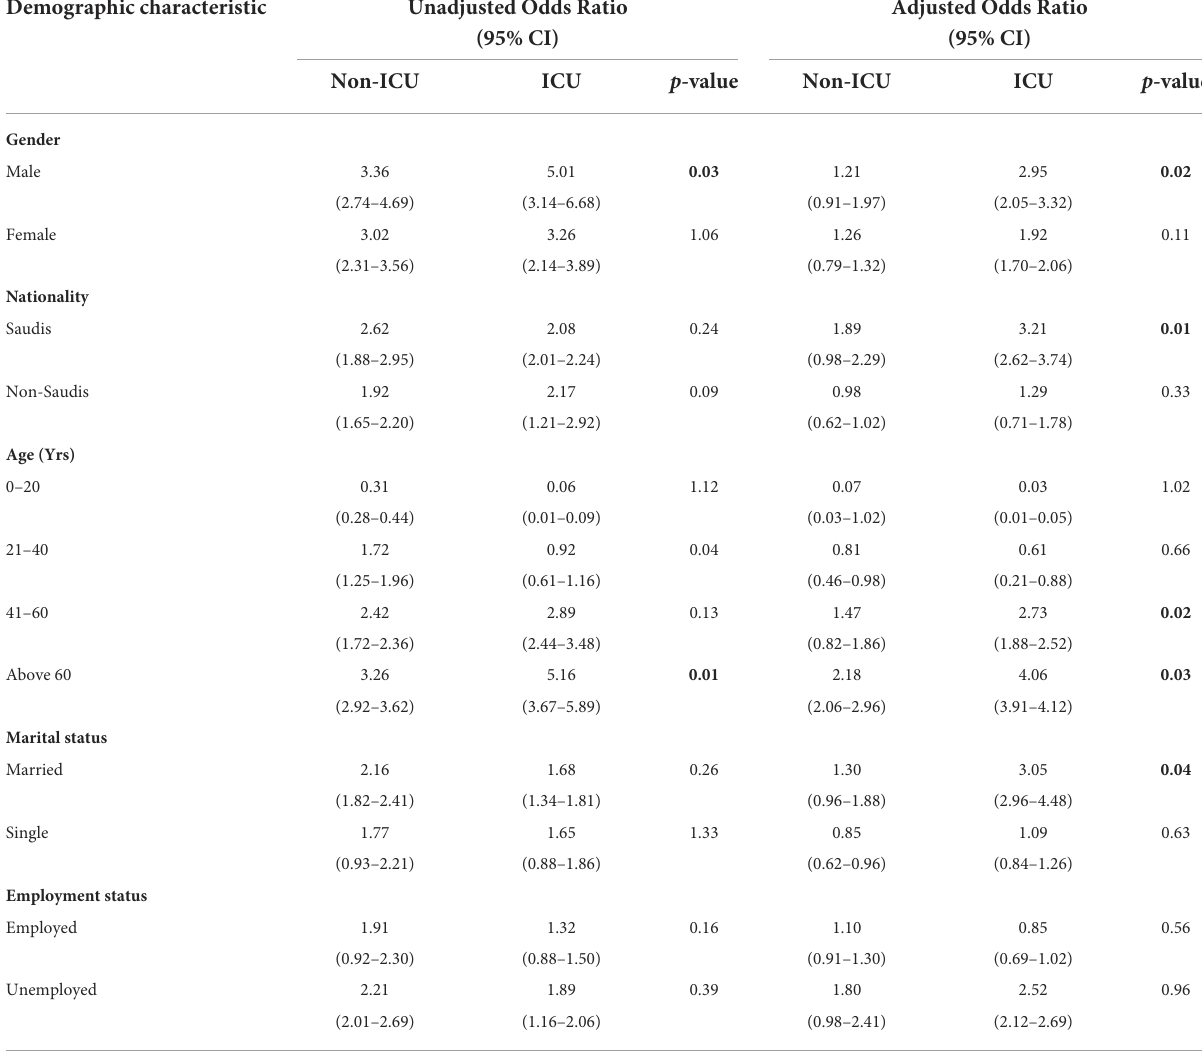
TABLE 3 Association between potential risk factors and COVID-19 hospitalization depending on demographic